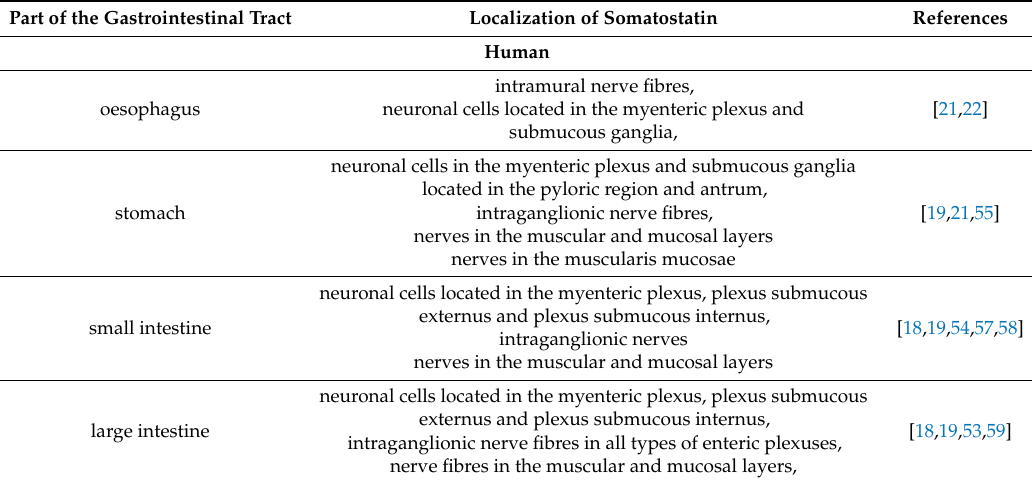
Table 1. Distribution of somatostatin in the nervous structures located in the wall of the gastrointestinal tract in the human, domestic pig and guinea